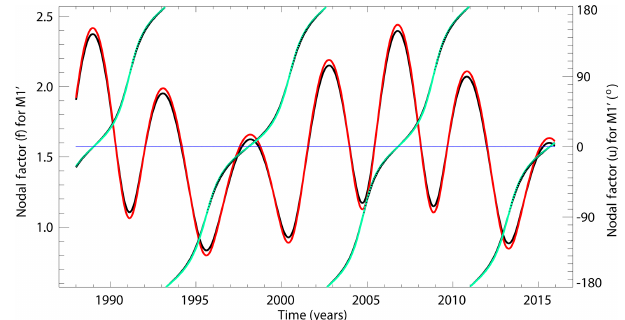
Figure 4. Variation of f as given by Eqs. (1a) and (1b) as a func- tion of time (in black), with an average value of approximately 1.57 owing to an historical normalization explained in Doodson (1928). This is accompanied closely (in red) by values one would obtain using amplitudes in Cartwright and Tayler (1971), normalized so as to have the same average value. The f values are with respect to the left axis. And variations in u from Eqs. (1a) and (1b) (in black) are closely accompanied (in green) by the corresponding values using Cartwright and Tayler (1971). The u values are with respect to the right axis. The f values in the second case span a slightly larger range than in the first case, while u values in the two cases are al- most identical and so the black and green curves